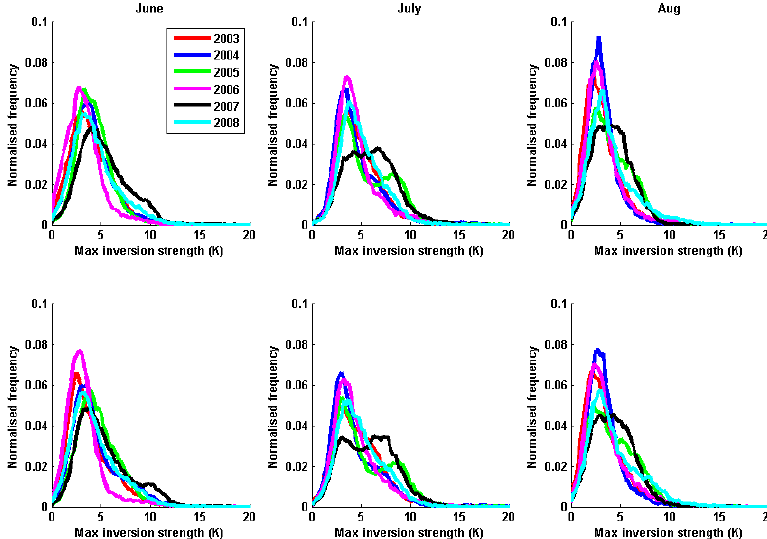
Fig. 3. The PDFs of inversion strength (in K) for the summer months. Top and bottom rows are for the ascending and descending passes.